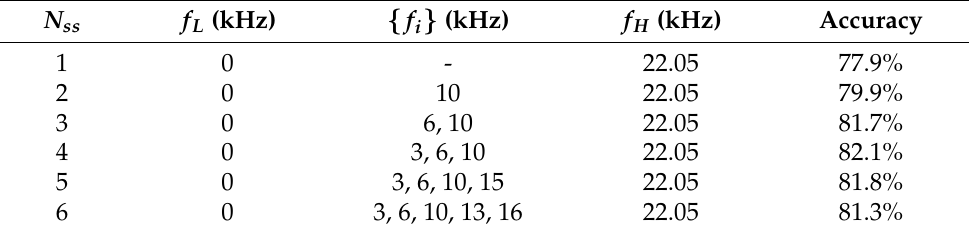
Table 1. Classification accuracy under different values of N ss